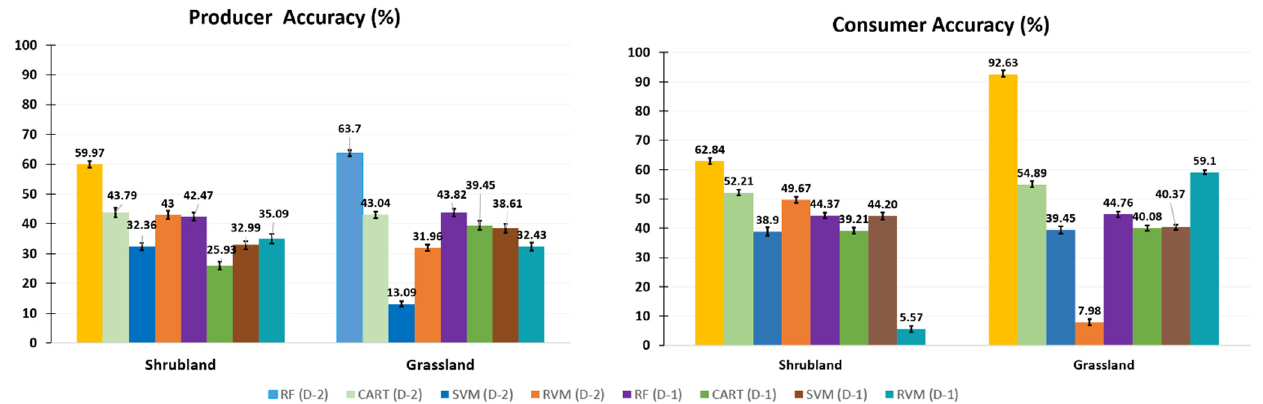
Figure 9. Average producer’s and user’s accuracies of Shrubland and Grassland for RF, CART, SVM, and RVM classifiers on dataset D-1 and D-2. The label above the bar shows the respective accuracy values, and their error bar indicates the standard deviation for 100 trials.